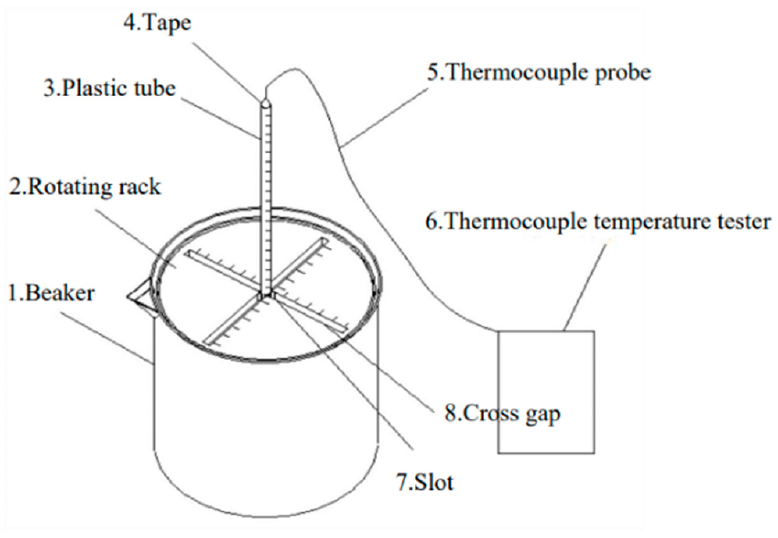
Figure 2. Schematic diagram of the temperature measurement device.